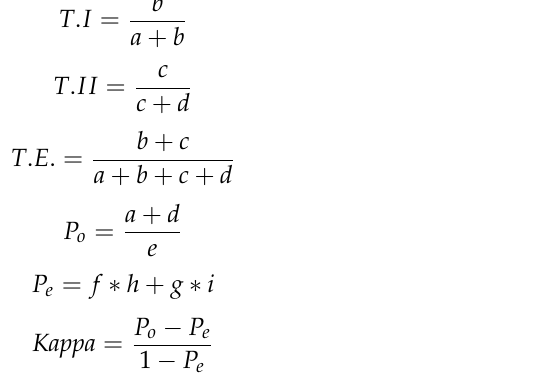
Table 2. The cross matrix between the reference results and ground filtered results.